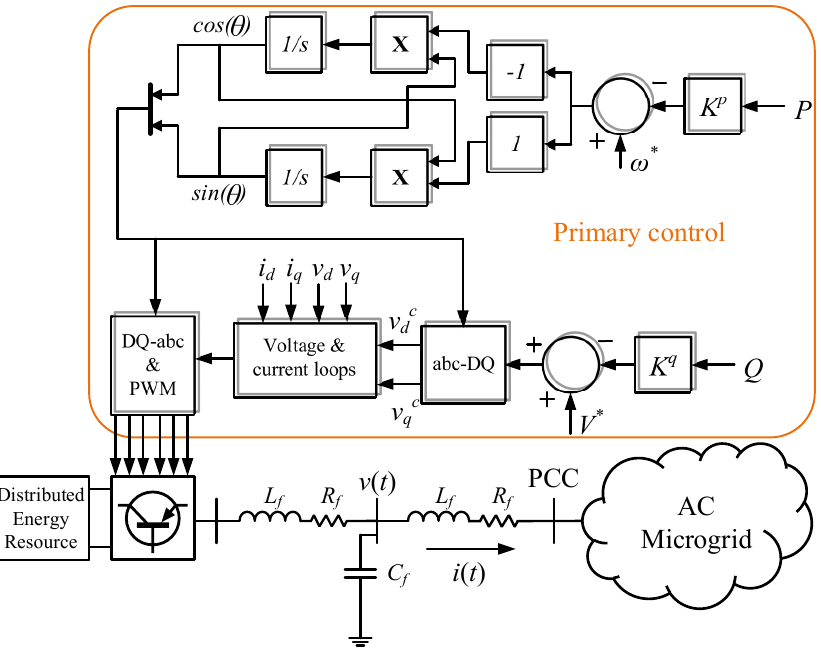
Figure 2. Droop control block diagram, autonomous system.